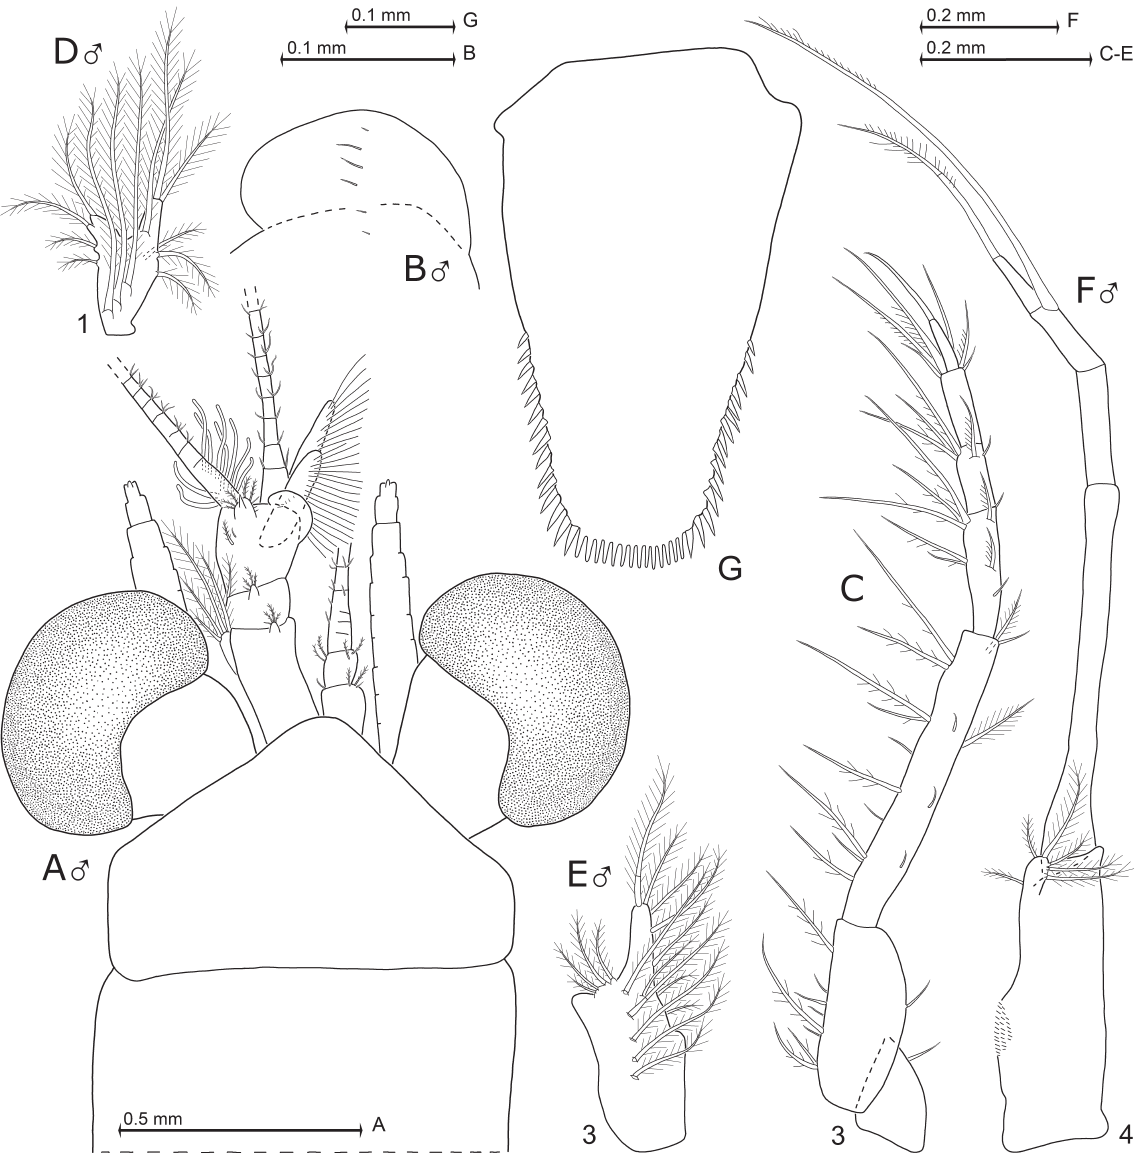
Fig. 3. Mysidium cubanense Băcescu & Ortiz, 1984, from Cuba (A), Curaçao (B–F) and Bonaire (G). A . Holotype, ♂, 5.1 mm body length. B–F . Non-type, ♂, 5.0 mm. G . Non-type, ♂, 4.0 mm. A . Cephalic region, right antennula and setae of antennal scale omitted. B . Mediodistal extension of left antennular trunk, dorsal view. C . Third thoracic endopod, rostral view. D – E . Pleopods 1 and 3, rostral view. F . Pleopod 4, caudal view. G . Telson. Sample affiliation: Cuba - type locality (A); Curaçao #C3 (B–F); Bonaire #B11